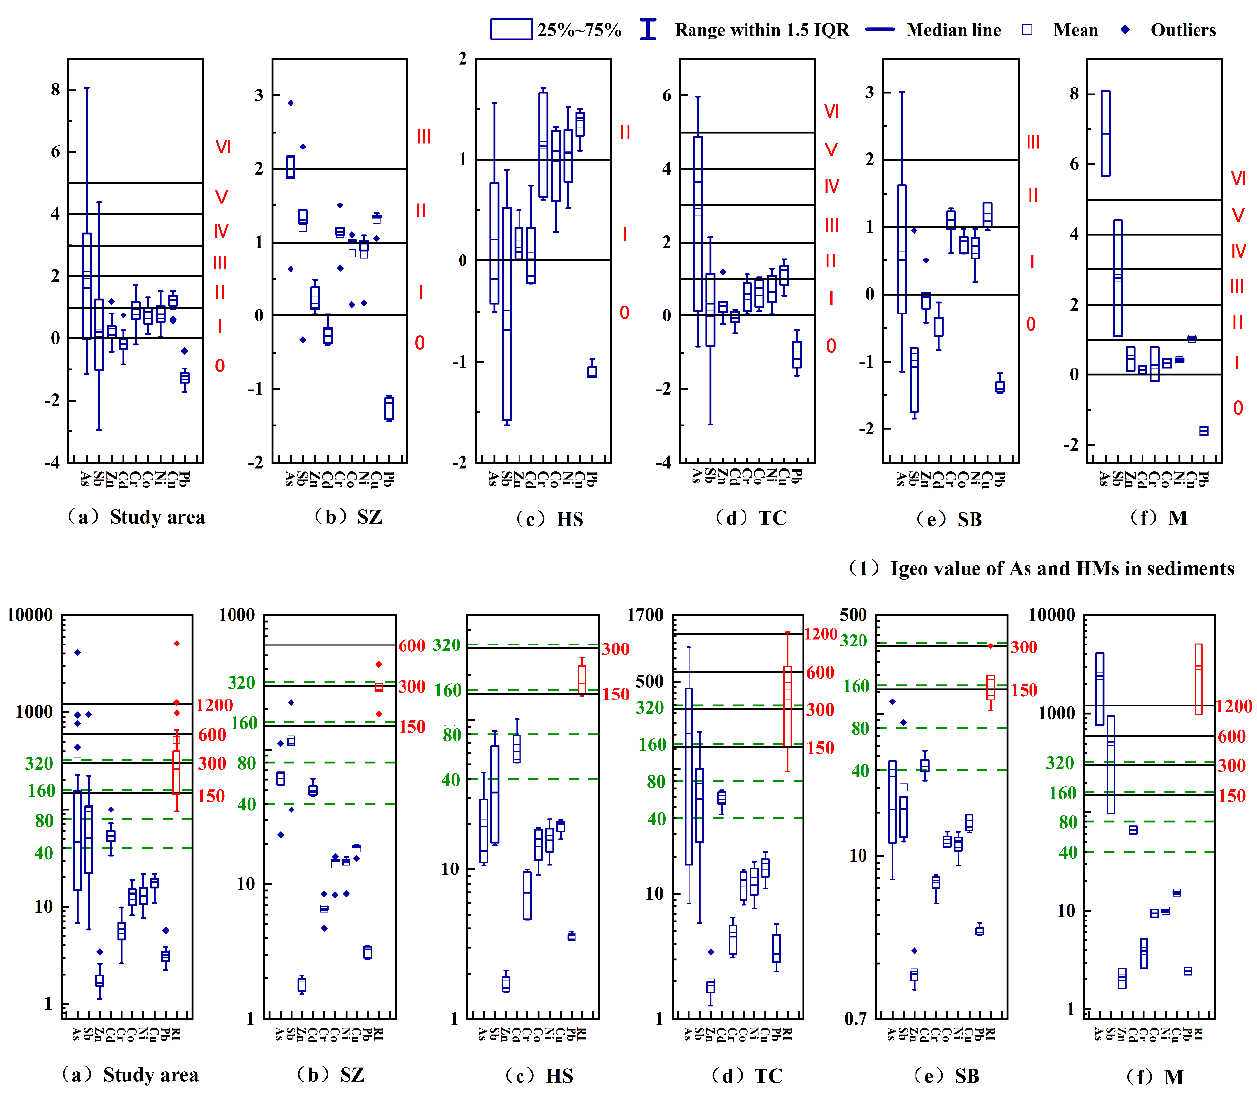
Figure 6. Comparison of Igeo, Eir and RI of As and HMs in sediments of gold mine area and four karst rivers. ( 1 ) Igeo index: level 0, representing no pollution; Grade I, representing no to moderate pollution; Grade II, representing medium pollution; Grade III, representing moderate to relatively high pollution; Grade IV, representing relatively high pollution to high pollution; Grade V, representing high pollution to extreme pollution; Grade VI, representing extreme pollution. ( 2 ) Eir index: <40, slight risk; 40–80, medium risk; 80–160, relatively high risk; 160–320, high risk; ≥ 320, extremely high risk.RI index: <150, slight risk; 150–300, medium risk; 300–600, relatively high risk; 600–1200, high risk; ≥ 1200, extremely high risk.